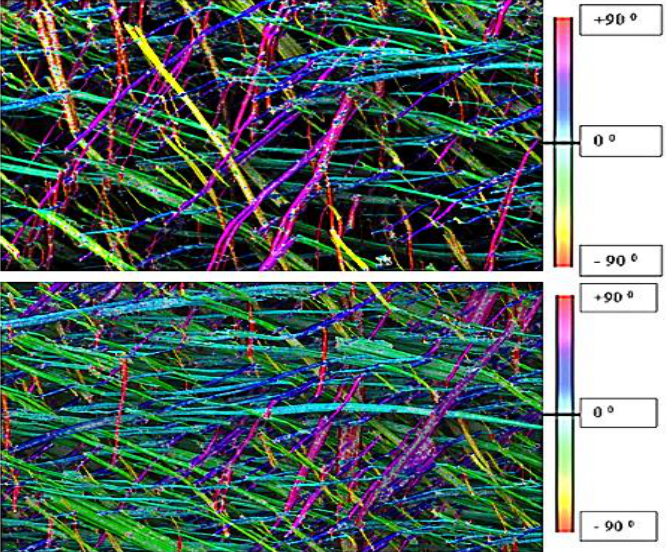
Figure 10. Colour coded maps obtained for the scanning electron micrographs of the selected fibre